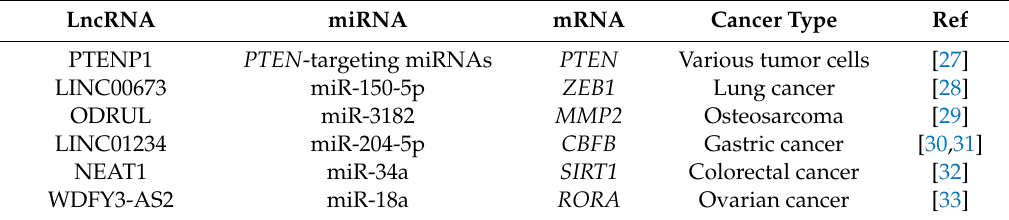
Table 1. Examples of the competing endogenous RNA (ceRNA)